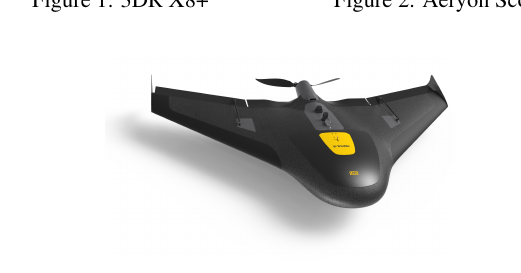
Figure 3: Trimble